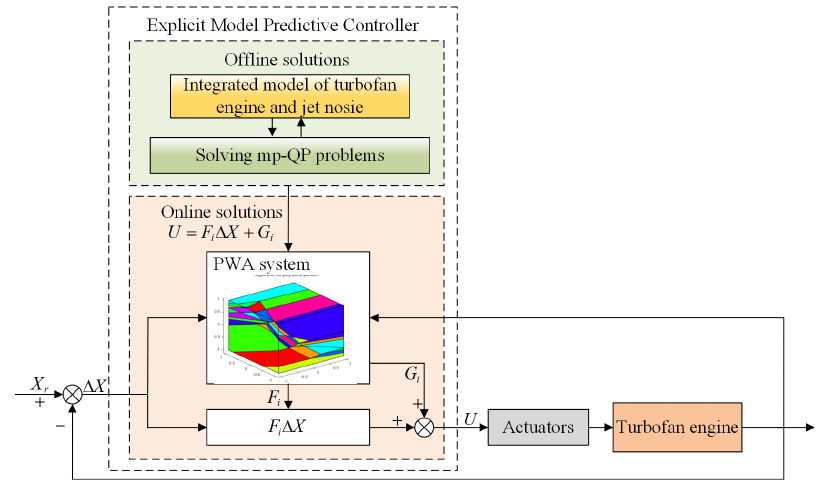
Figure 5. Active jet noise reduction controller structure based on explicit model prediction method.